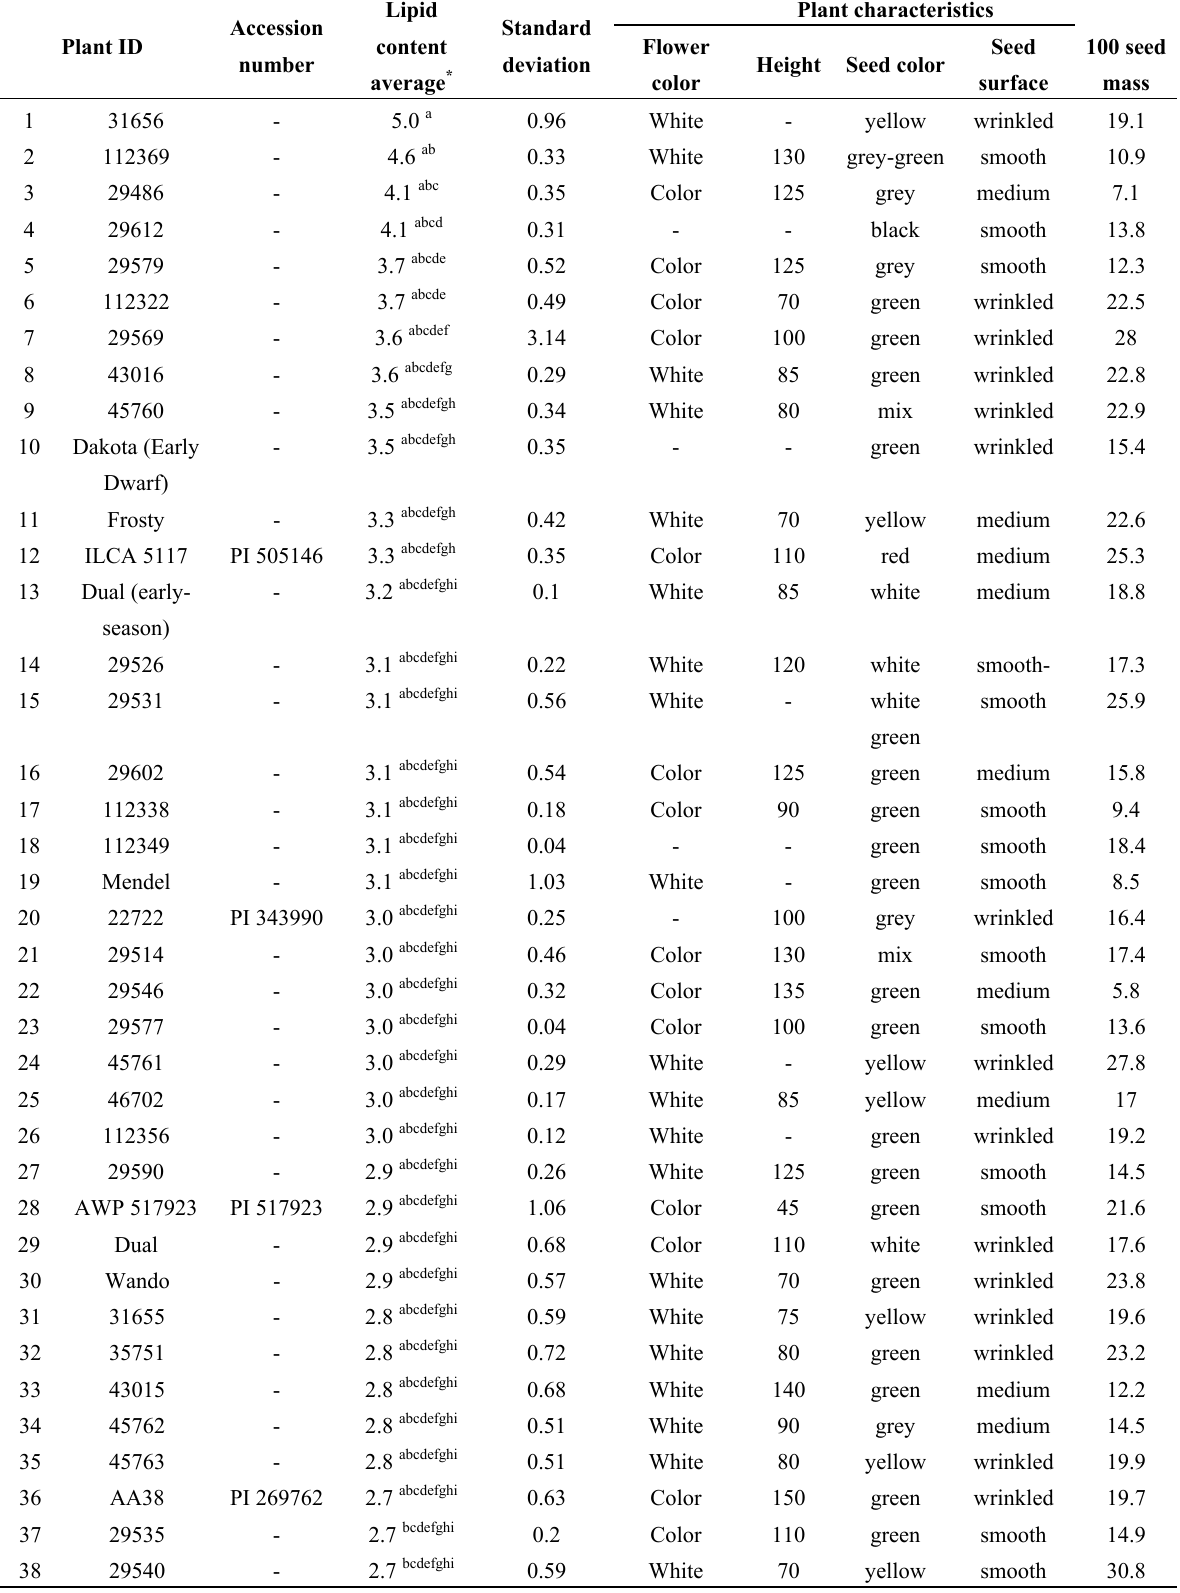
Table 2. Average lipid concentration in different pea accessions. Peas were grown in St. Anne de Bellevue, QC, Macdonald Campus of McGill University, in 2009 and 2010. Missing values are not